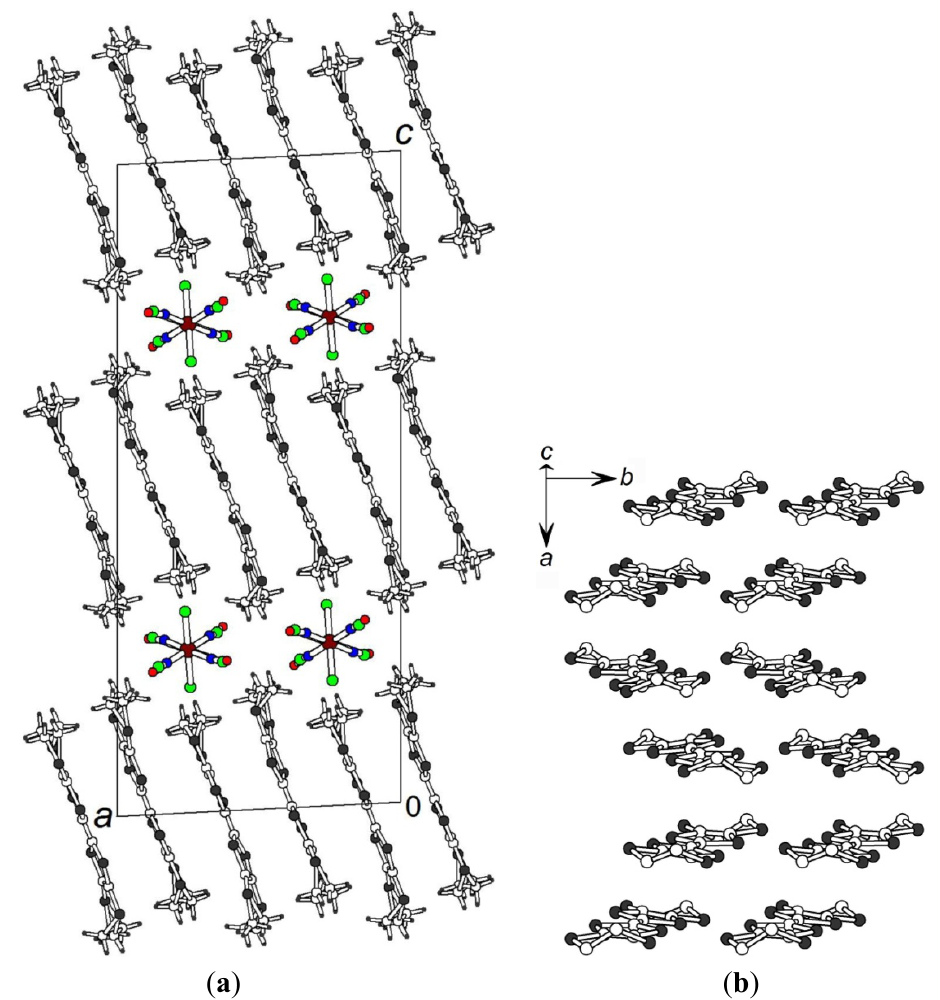
Figure 1. δ -(BEDT-TTF) Solvent molecules located in the plane of the disordered NO ligands of the anion are omitted for clarity; ( b ) Donor layer of δ -type projected along